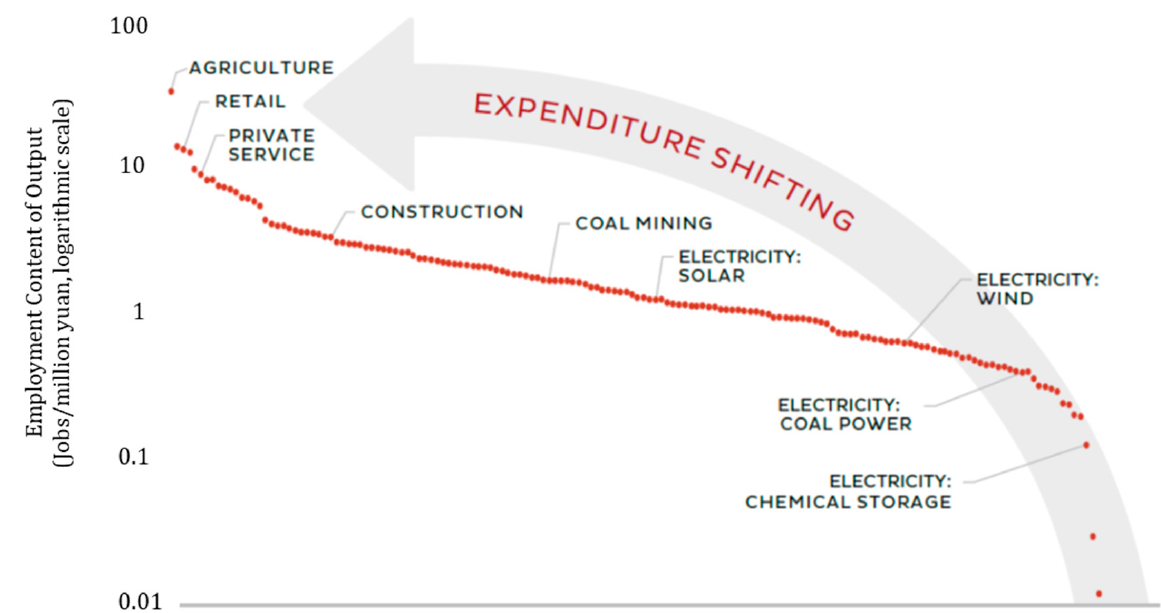
Figure 2. Employment Intensity by Sector, 2017. Source: Authors’ calculation from official data [44,46].